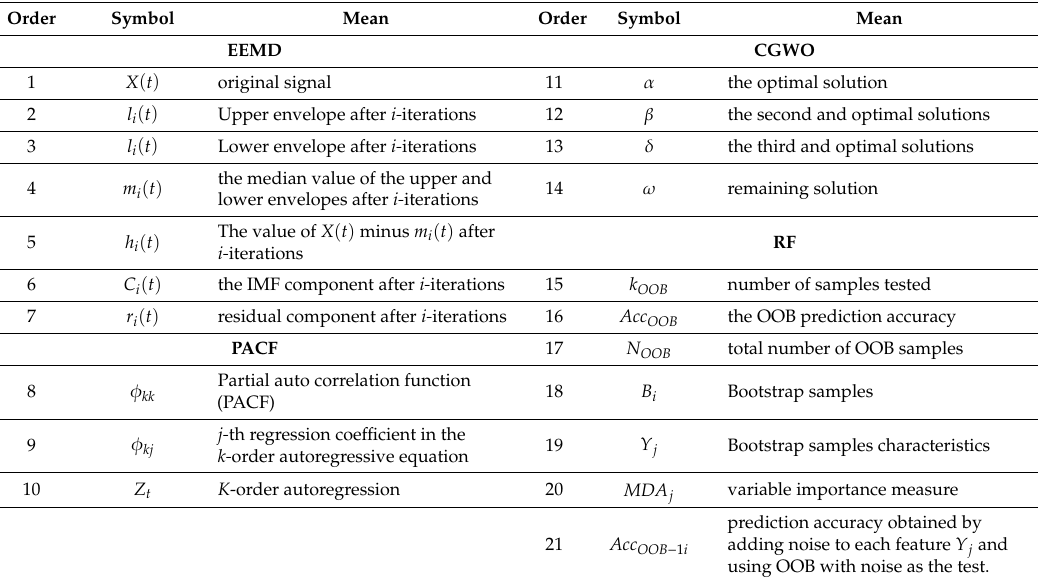
Table 1. The meaning of the symbols used in this